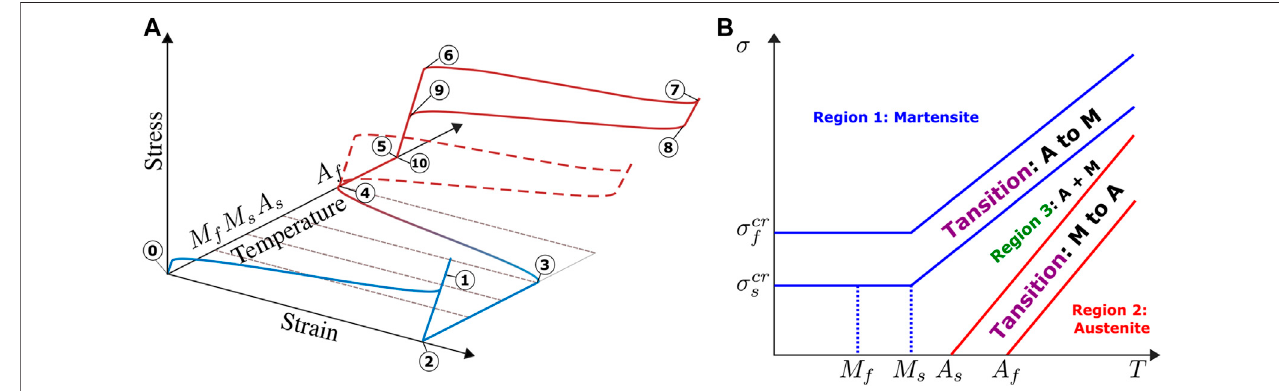
FIGURE 2 | (A) An example of modeling of 1D stress-strain-temperature constitutive behavior of SMA. Shape memory effect: (0) to (4), pseudoelastic loop at constant high temperature: (5) to (10), the hysteretical behaviors are different according to the different temperatures. The fi gure is inspired by (Shaw, 2002). (B) An example of Brinson ’ s phase diagram, the fi gure is inspired by (Brinson,